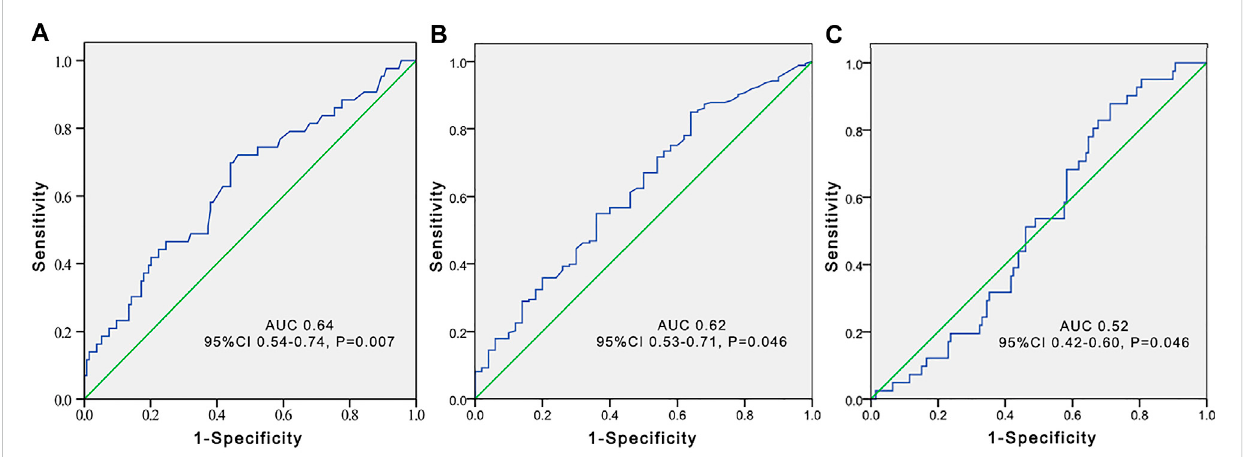
FIGURE 3 Receiver operating characteristic (ROC) curve to predict voriconazole trough concentrations greater than 5 μ g/ml according to the total bile acid level (A) , platelet count (B) , and estimated glomerular fi ltration rate (C) in younger adult